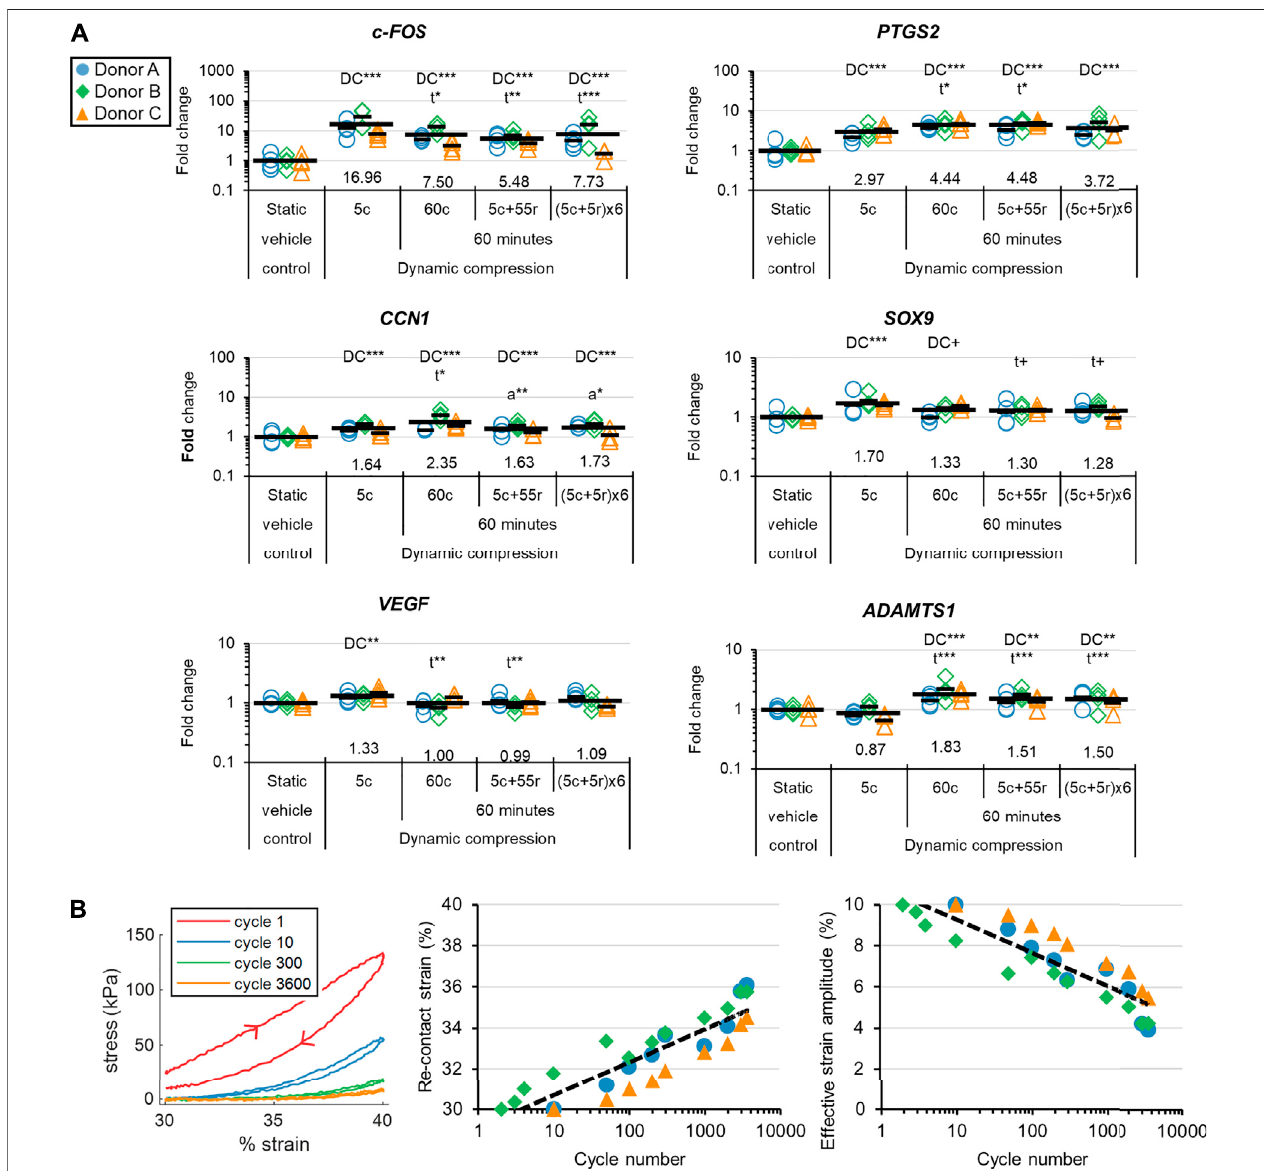
FIGURE 5 | Experiment II: (A) The gene expression effects of DC loading incident duration. Fold changes are with respect to the static vehicle control group within each donor, and values for each gene of interest are normalized to the mean expression of housekeeping genes β -actin , B2M , and YWHAZ . Expression was measured 30 minaftertheloadingevent. “ DC ” indicatesthatagroupissigni fi cantlydifferentthanthestaticvehiclecontrol. “ t ” indicatesthataDCgroupissigni fi cantlydifferentthan 5c. “ a ” indicatesthata60-mingroupissigni fi cantlydifferentthan60c.***: p < 0.001,**: p < 0.01,*: p < 0.05,+: p < 0.10. (B) Loadinganalysisforthe60cgroup.The arrowheads show the direction of onloading and of fl oading. The re-contact strains were de fi ned as the points within the compression phase when the force rose above 0 N, indicating contact. The effective strain amplitudes are calculated as 40% minus the strain at the re-contact points.